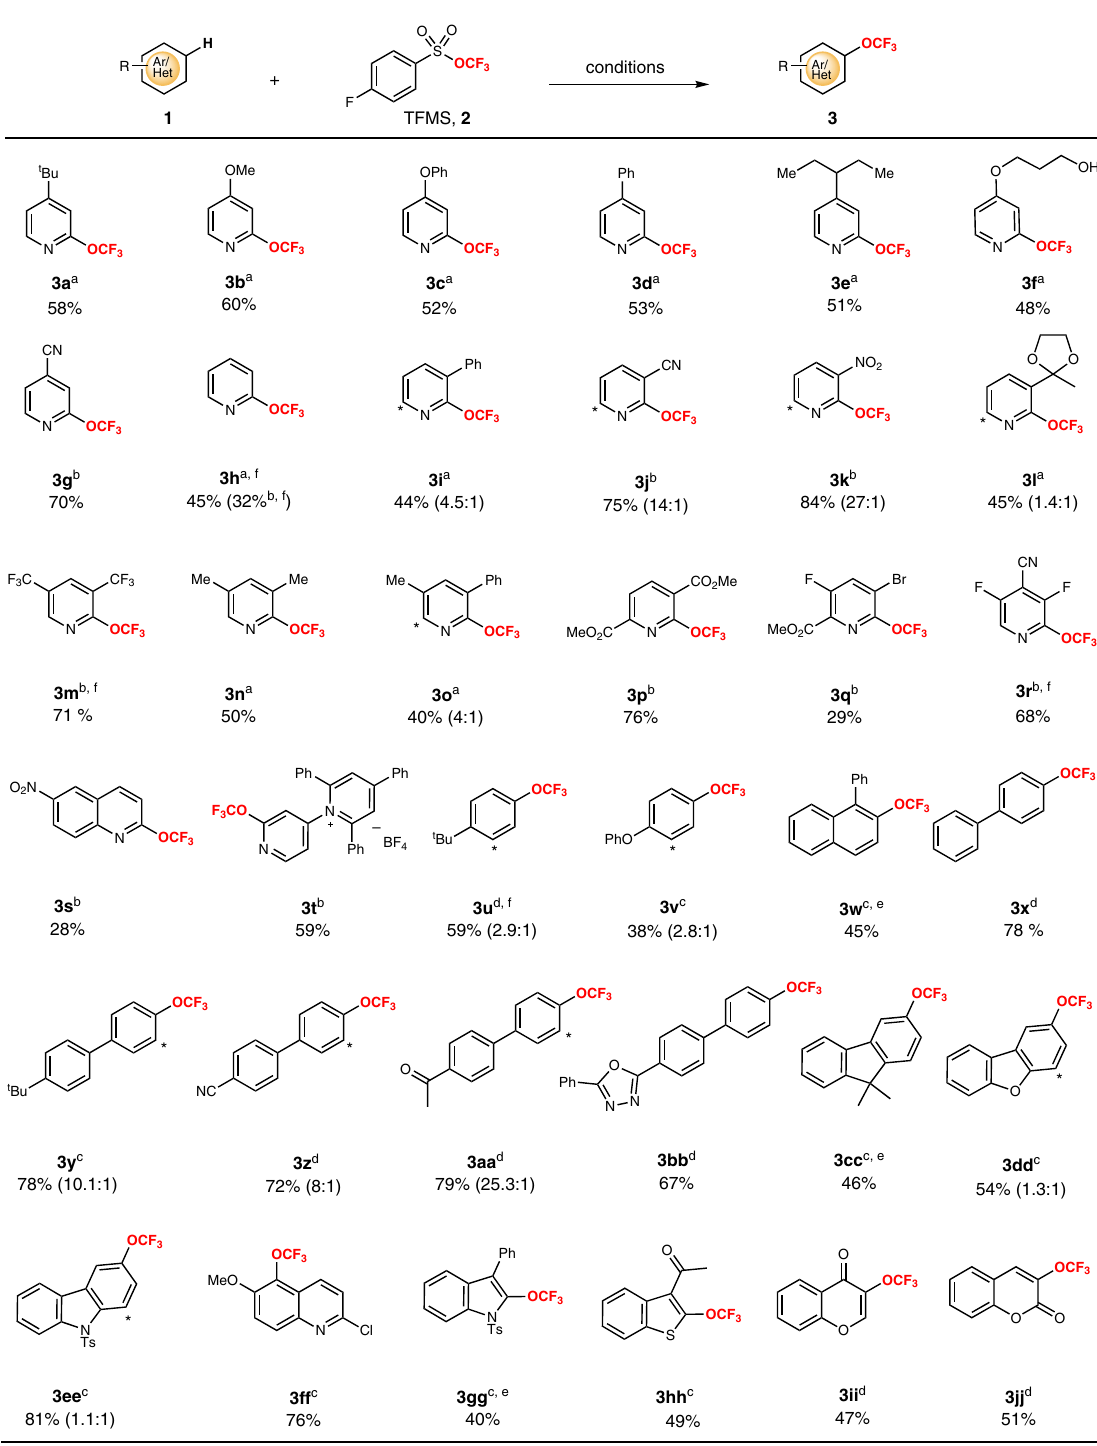
Fig. 2 Substrate scope of simple arenes and heteroarenes. a Method A: 1 (1.0 equiv), AgF 2 (1.0 equiv), TFMS ( 2 ) (3.0 equiv), Select fl uor (2.0 equiv), CsF (3.0 equiv), DMC, N 2 , 35 °C. b Method B: 1 (1.0 equiv), AgF 2 (4.0 equiv), TFMS ( 2 ) (4.0 equiv), MeCN, N 2 , 10 °C. c Method C: 1 (1.0 equiv), AgF 2 (1.0 equiv), TFMS ( 2 ) (4.0 equiv), Select fl uor (2.0 equiv), CsF (4.0 equiv), 4- tert -butyl-2,6-bis(4- tert -butylpyridin-2-yl)pyridine (0.1 equiv). DMC, N 2 , 35 °C. d Method D: 1 (1.0 equiv), AgF 2 (4.0 equiv), TFMS ( 2 ) (4.0 equiv), di(pyridin-2-yl)methanone (0.1 equiv), MeCN, N 2 , 10 °C. e K 2 S 2 O 8 was used instead of Select fl uor. f Yields were determined by the 19 F NMR spectrum using benzotri fl uoride as internal